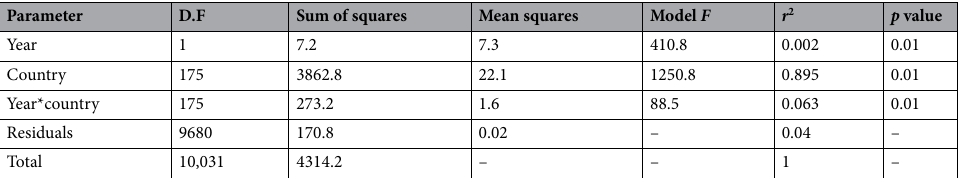
Table 2. Results from an Adonis test evaluating changes in crop commodity group composition at national scales from 1961 to 2017. The distance matrix employed in this analysis was based on non-metric multidimensional scaling, whereby cultivation area was used as an estimate for crop group abundance. Results are presented visually in Figure S1.